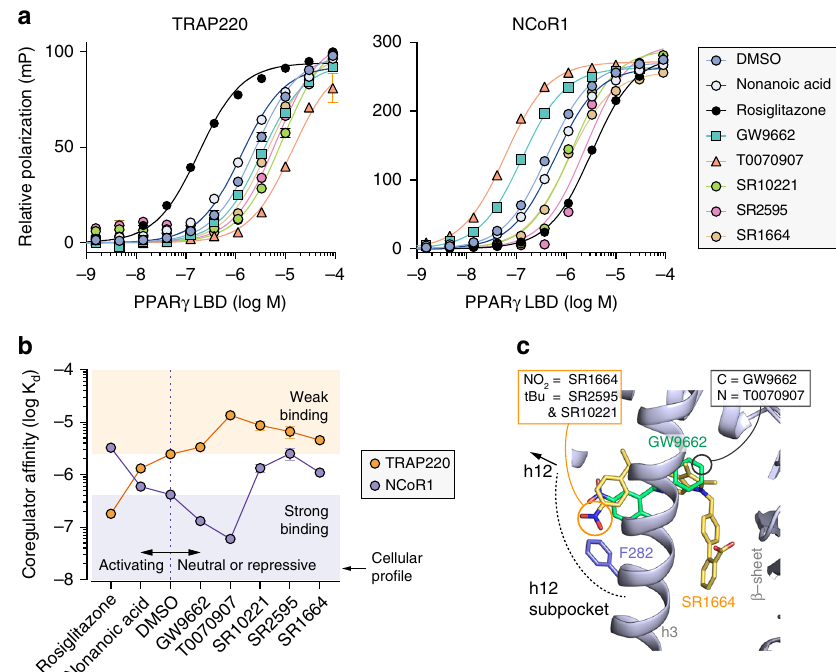
Fig. 2 Coregulator binding pro fi les of the activating, neutral, and repressive synthetic PPAR γ ligands. a Fluorescence polarization coregulator interaction assay showing the effect of ligands on the interaction between the PPAR γ LBD and peptides derived from the TRAP220 coactivator or NCoR1 corepressor, plotted as the mean ( n = 2) with error bars representative of s.d. b K d values derived from the coregulator interaction assay. Dotted orange and purple lines note the DMSO/apo-PPAR γ values. Orange and purple shaded areas note the af fi nity regions for an ideal inverse agonist (i.e., for weaker TRAP220 af fi nity, orange circles in the orange square; for higher NCoR1 af fi nity, purple circles in purple squares). c Superposition of crystal structures of the PPAR γ LBD bound to GW9662 (PDB code 3B0R; ligand in green, cartoon in blue) and SR1664 (PDB code 4R2U; ligand in yellow). The location of the simple substitution between GW9662 (methine) vs. T0070907 (nitrogen) is marked with a black circle, and the SR2595 and SR10221 tert-butyl extension within the helix 12 subpocket towards F282 (blue) from the SR1664 parent compound is marked with a yellow circle. Data are representative of at least 3 independent Table 1) and compared our structure to an available crystal